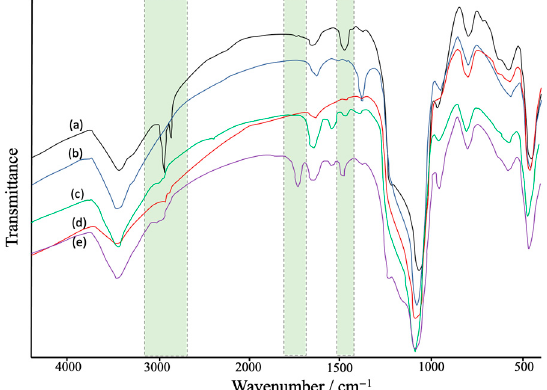
Figure 2. FTIR spectra: (a) Fe 3 O 4 -MSNs with CTAB, (b) CTAB free Fe 3 O 4 -MSNs, (c) Fe 3 O 4 -MSNs- NH 2 (d) Fe 3 O 4 -MSNs-Br, and (e) Fe 3 O 4 -MSNs-PMETAC.